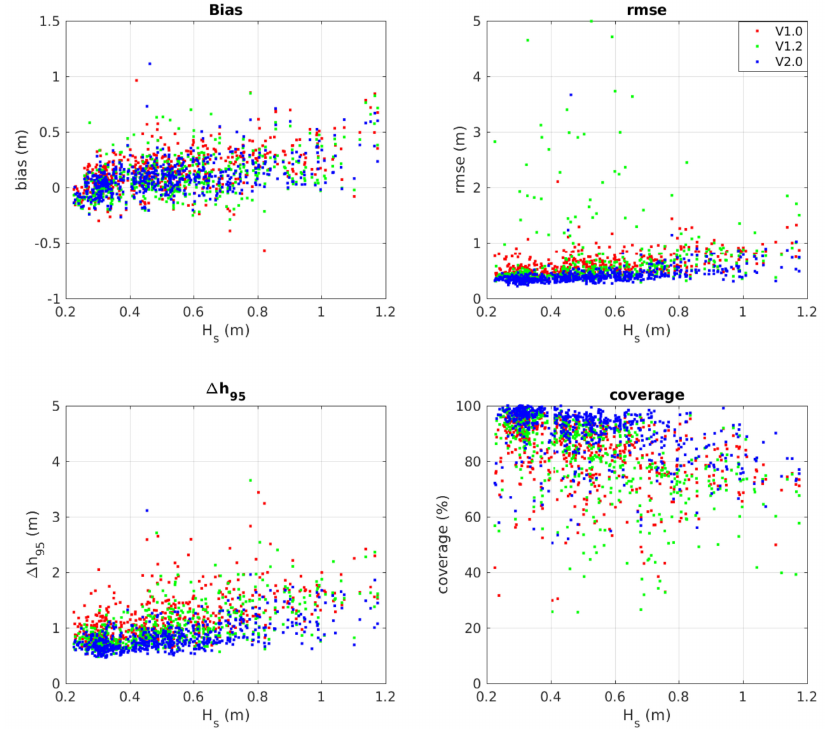
Figure 17. Comparison scatter plots of the four performance statistics for each of the three algorithm versions (see legend at top right) for the reduced dataset of 563 runs. Points are plotted in order, so blue points (V2.0) overplot earlier